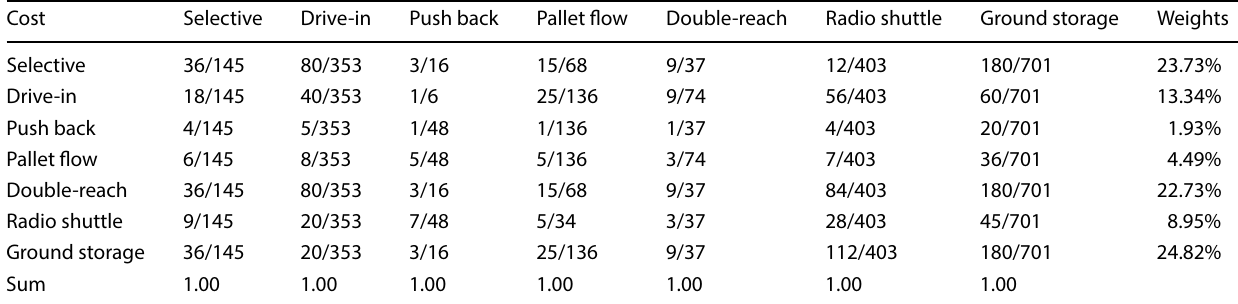
Table 9 Normalized matrix for the cost criterion